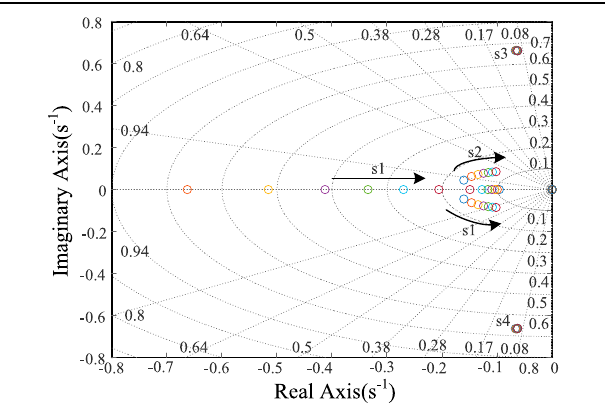
FIGURE 14 | Eigenvalues when D = 10 and H